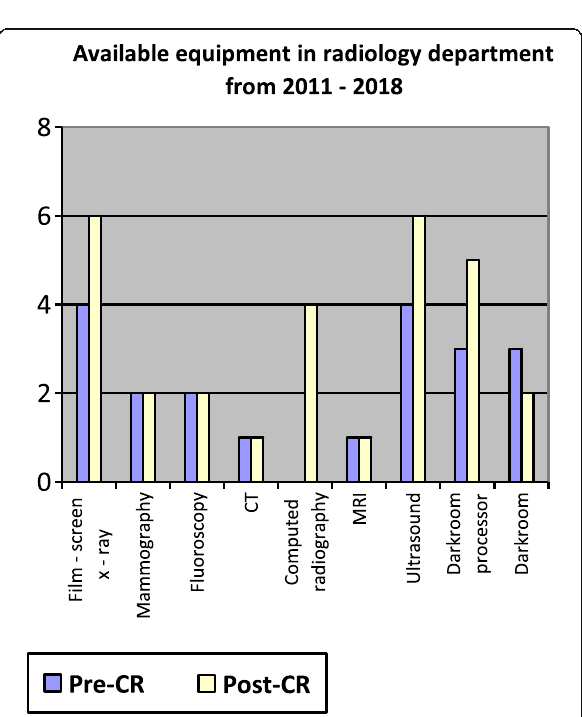
Fig. 5 Compound bar chart of modalities and equipment available for radiographic imaging